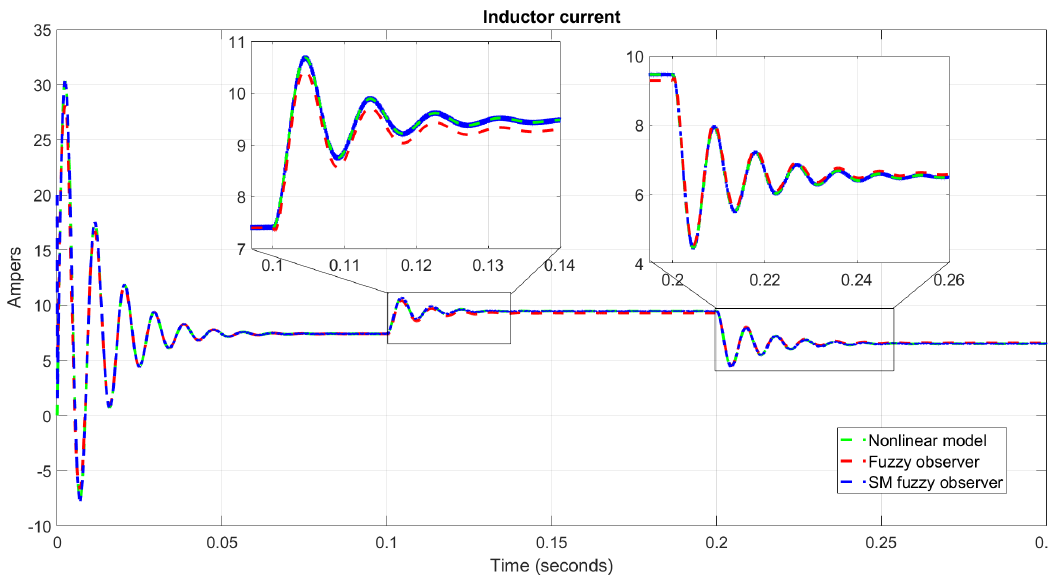
Figure 18. Observer response on inductor current i L with variations in load R .